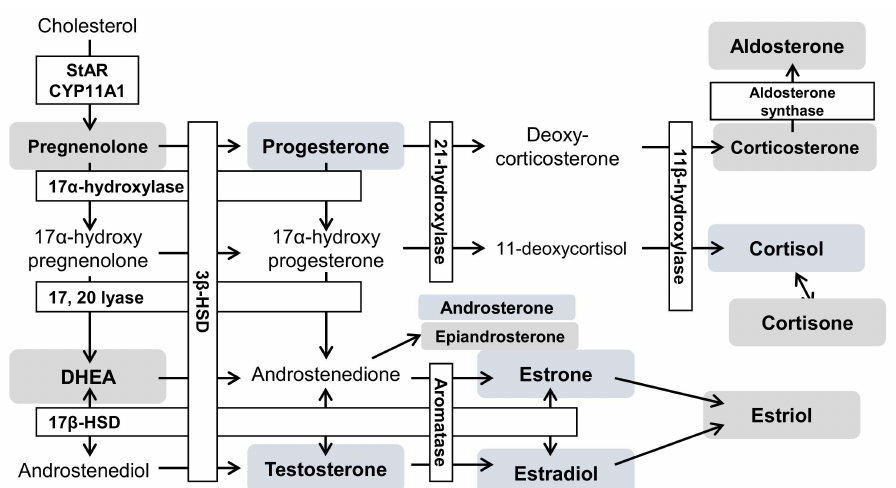
Figure 6. The hypothesis of an altered steroid hormone metabolism in NPC. Blue boxes indicate a decrease; gray boxes indicate no change. The open text indicates the absence of analytes in this study. CYP11A1, cytochrome P450 family 11 subfamily A member 1; 3 β -HSD, 3 β -hydroxysteroid dehy- drogenase; 17 β -HSD, 17 β -hydroxysteroid dehydrogenase; CYP11B1, 11 β -hydroxylase; CYP11B2, aldosterone synthase; CYP17A, 17 α -hydroxylase/17,20 lyase; CYP19A, aromatase; CYP21A, 21- hydroxylase; DHEA, dehydroepiandrosterone; StAR, steroidogenic acute regulatory